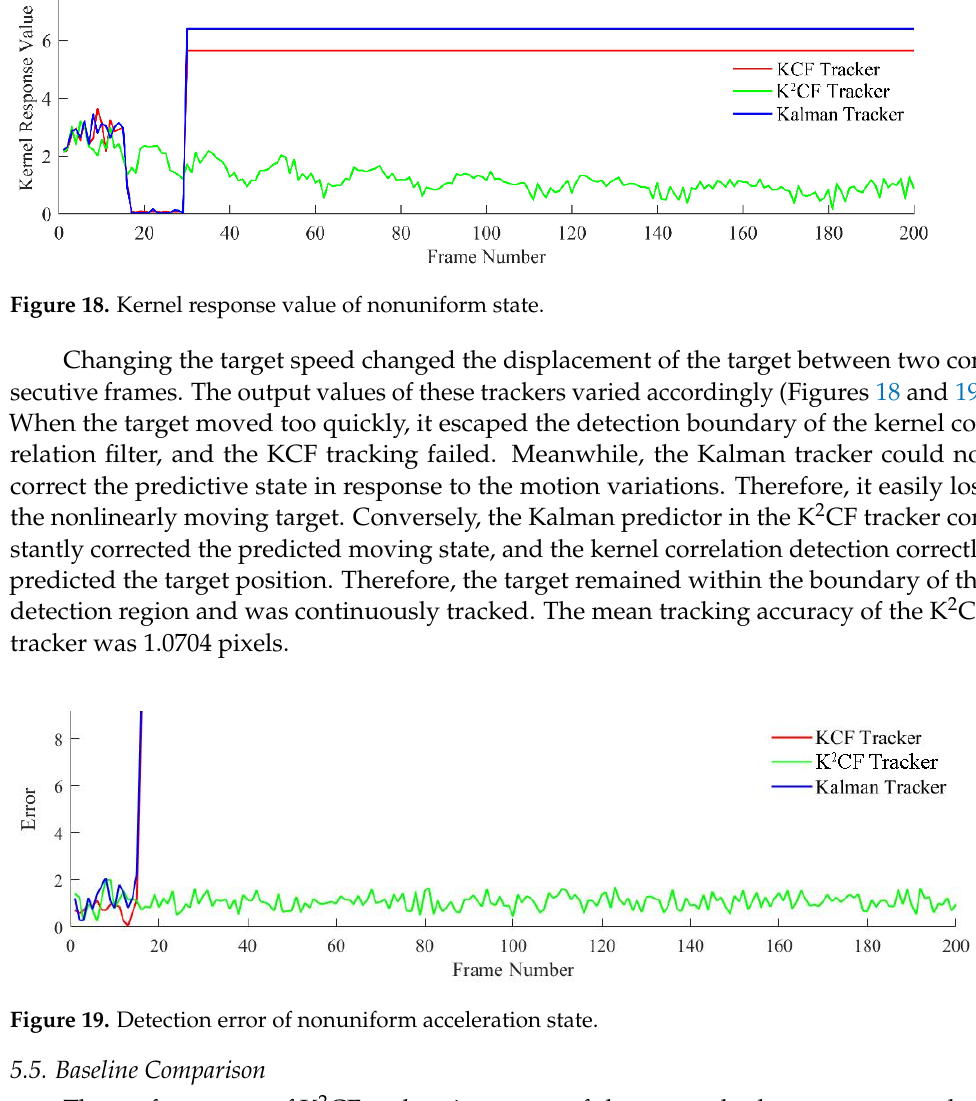
Figure 17. Adaptive velocity adjustment.